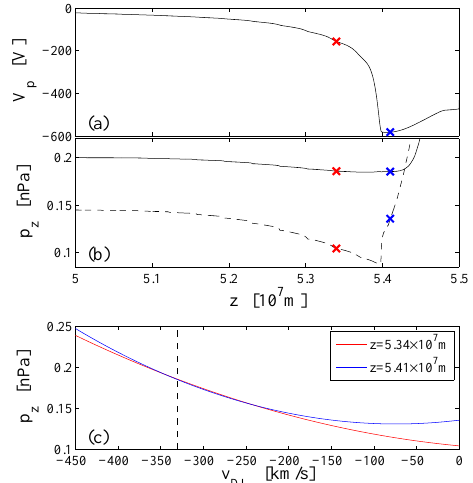
Figure 6. Application of the generalised Langmuir condition at t = 3s in the run with V p , I = − 400V and 4 × 10 7 m − 3 . The panels show (a) the plasma potential; (b) the field-aligned pressure p z in the moving frame (solid line) and in the stationary frame (dashed line); and (c) p z (v DL ) for z 1 = 5 . 34 × 10 7 m (red) and z 2 = 5 . 41 × 10 7 m (blue). These positions are also marked in panels (a) and (b) . The vertical dashed line in panel (c) marks v DL = 331kms − 1 , which is the velocity of the moving frame used to plot p z (z) in panel (b) .